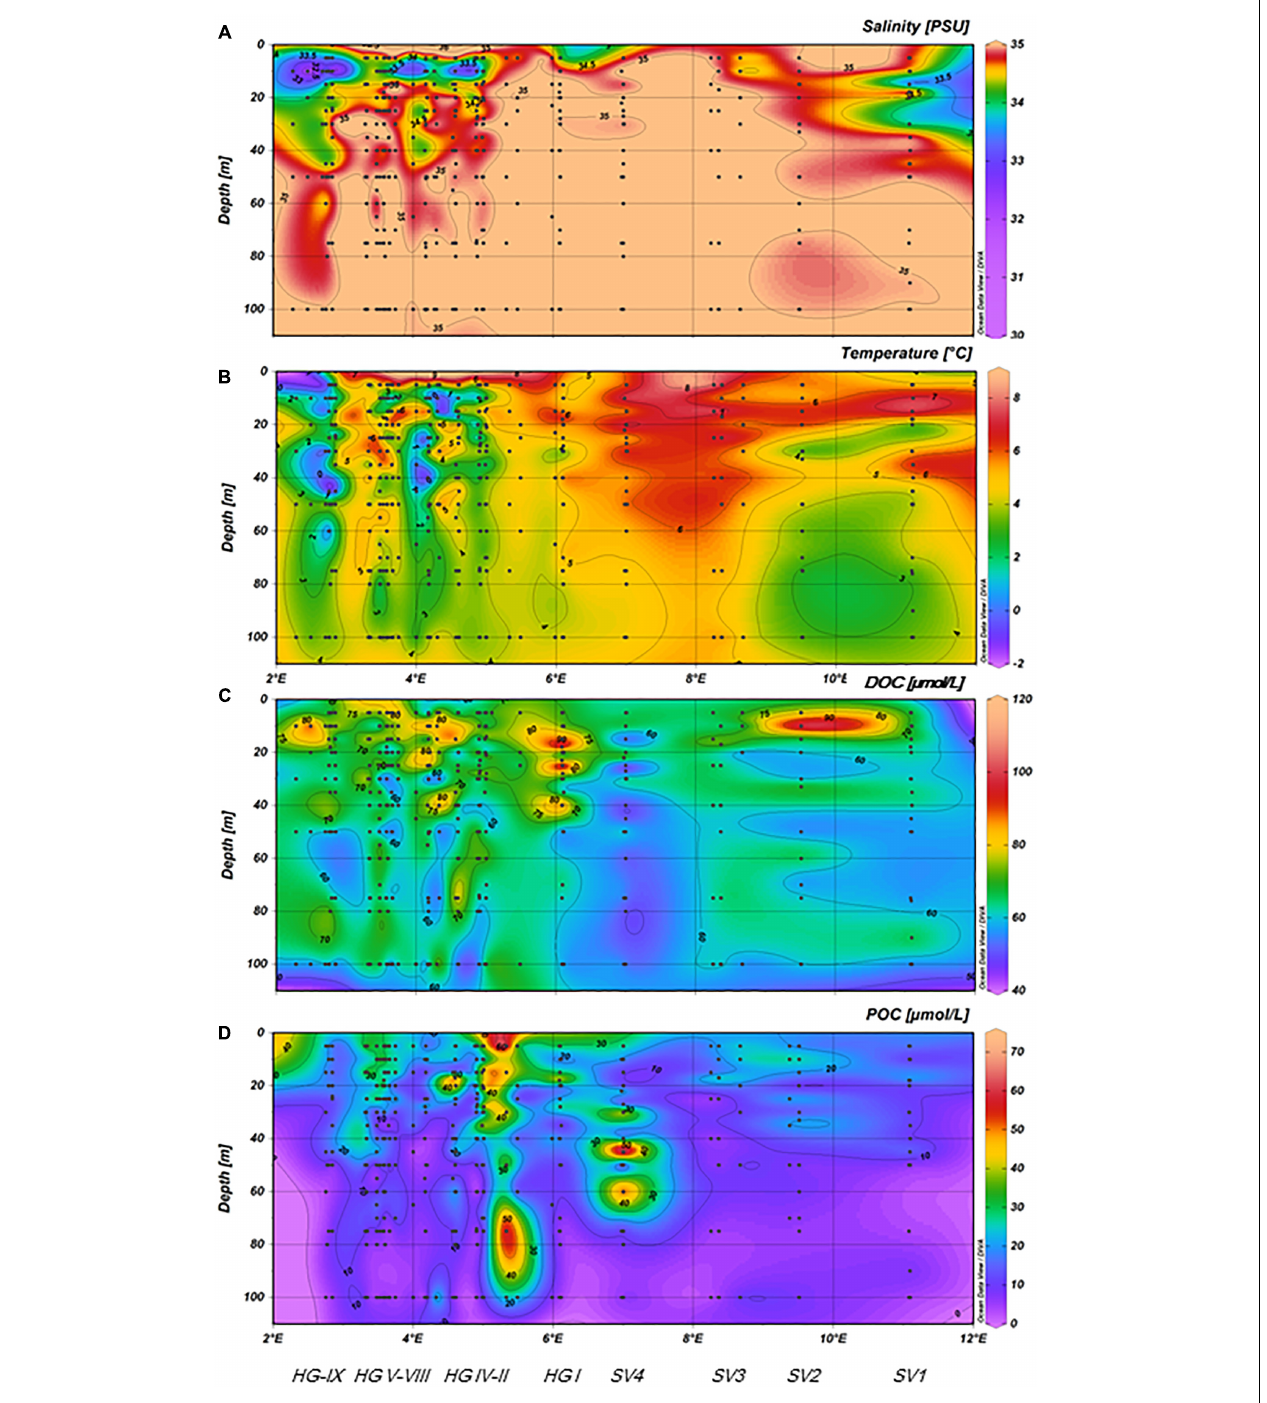
FIGURE 9 | (A–D) Spatial variability of salinity, temperature, DOC, and POC concentration along the ∼ 79 ◦ N latitude during 2009–2017 (merged data).